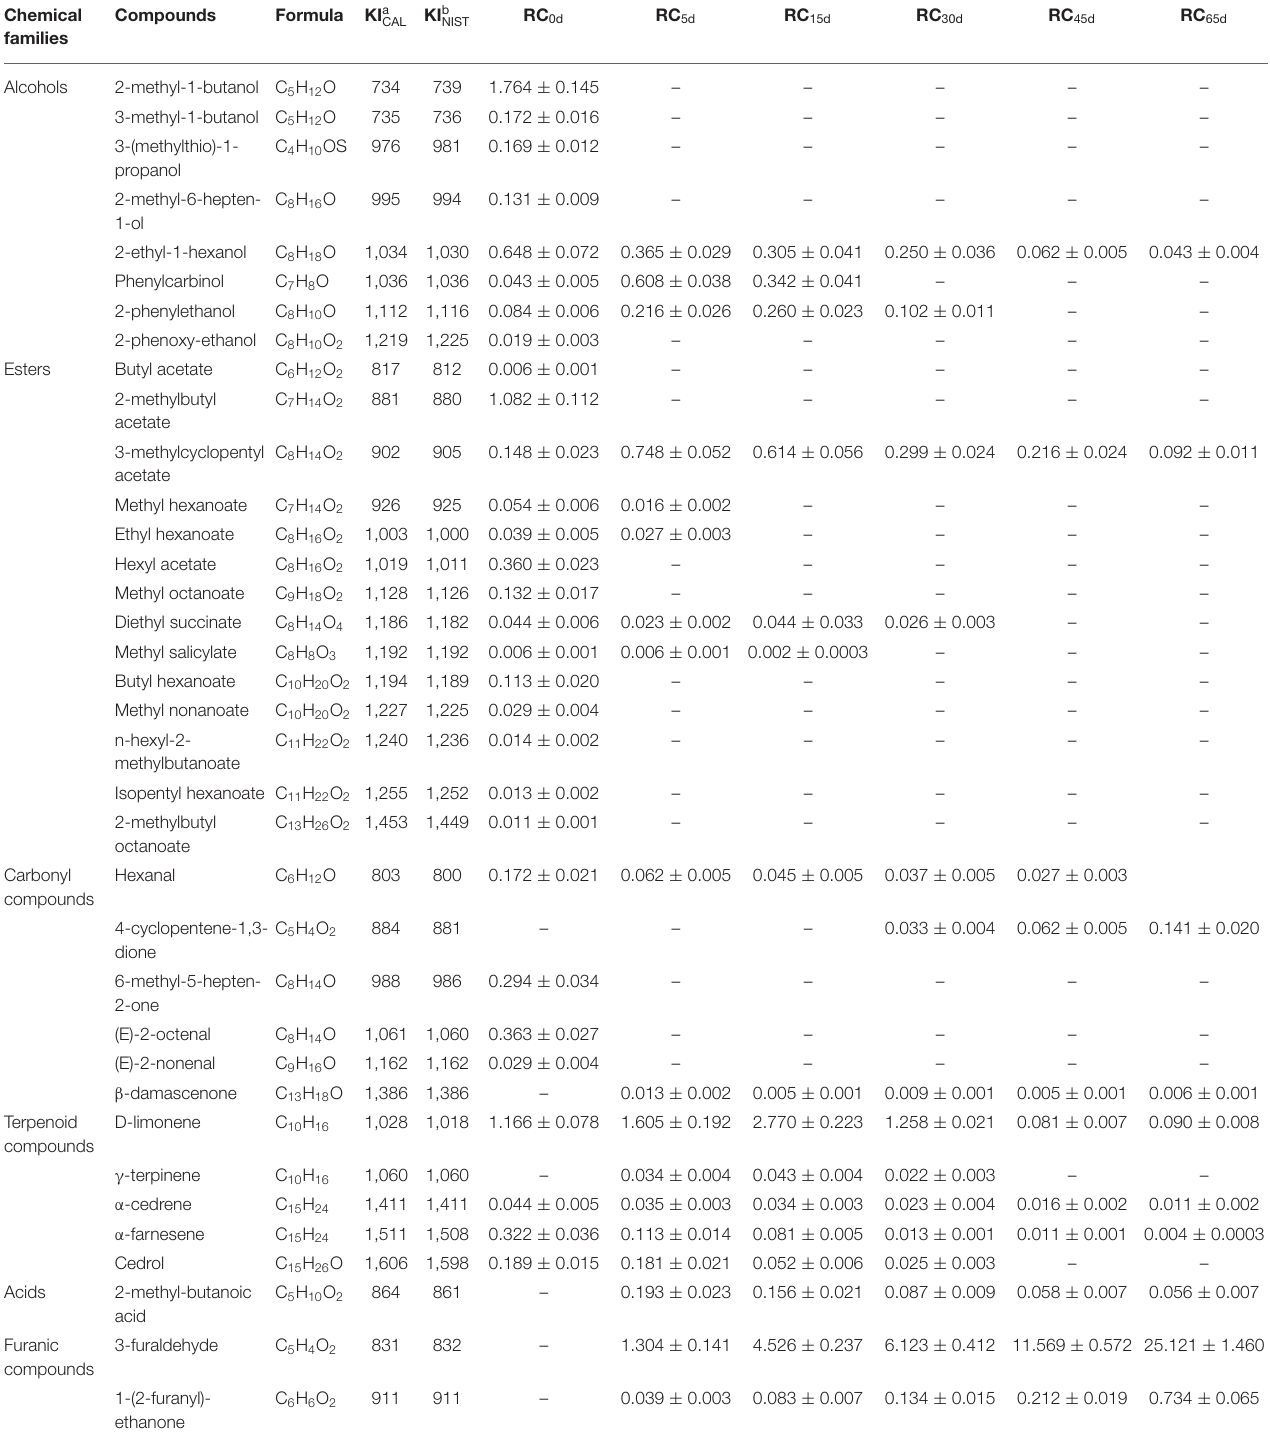
TABLE 1 | Volatile compounds identified in apples with different fermentation time and their relative contents. Chemical families